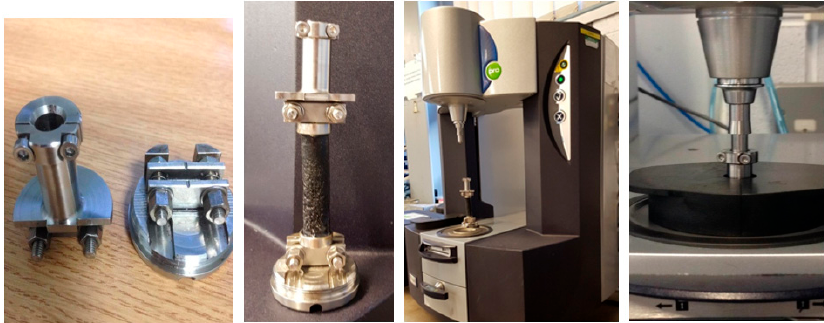
Figure 2. Mortar samples installation and test configuration.